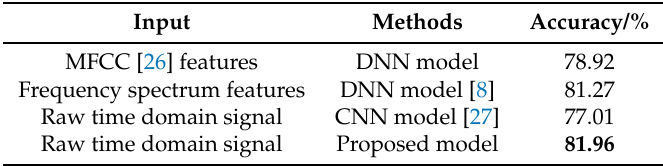
Table 3. Accuracy of different models.